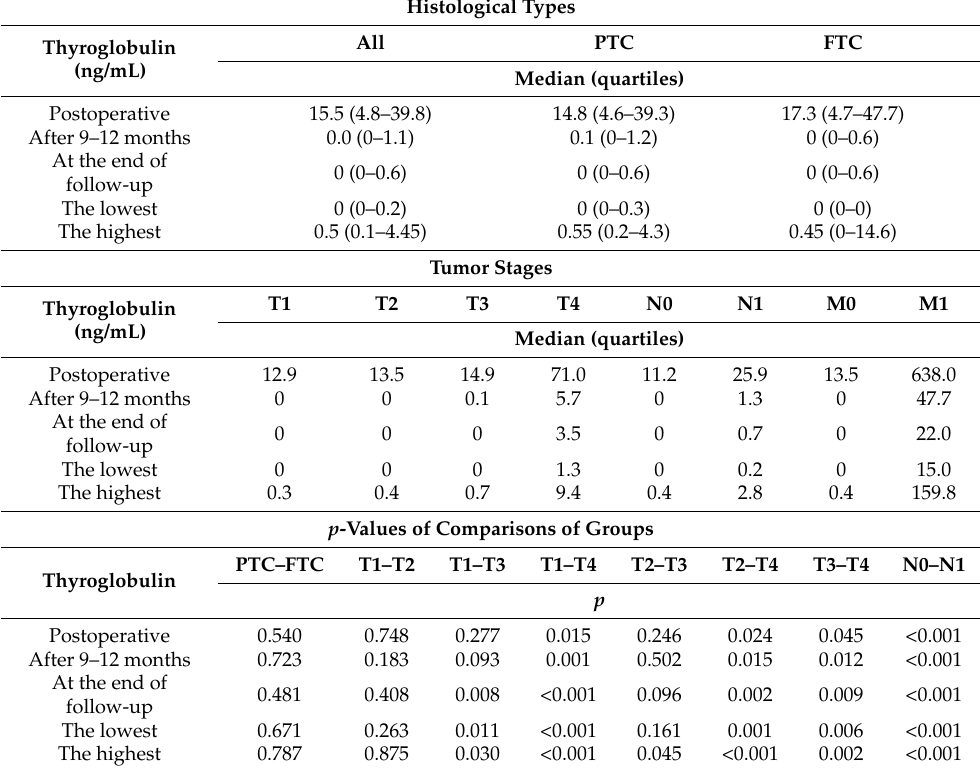
Table 3. Thyroglobulin values by histological types and tumor stages and p -values of comparisons of groups (in Kruskal–Wallis